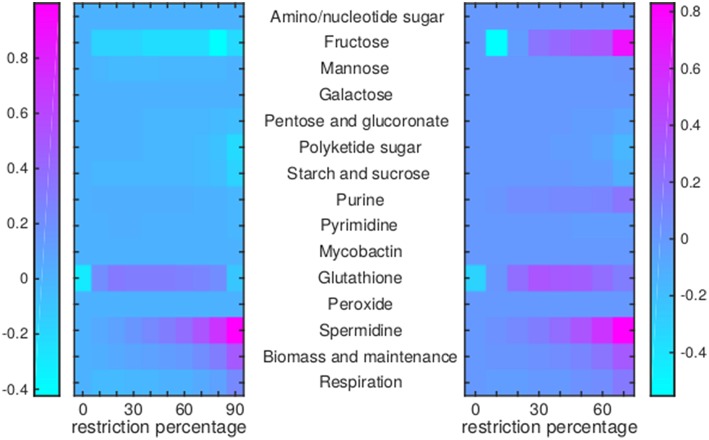
Flux rerouting through sugar metabolism, nucleotide metabolism, and various other metabolic pathways upon application of drugs. Heat maps indicate a predicted relative increase (pink) or decrease (light blue) through various pathways upon the application of a variety of drugs. The logarithm of the sum of all absolute fluxes is given per pathway (values are indicated in the color bars on either side), so information on directionality is not comprised. The x-axis indicates the percentage of restriction of the drug-affected reaction(s). Left: average of BTZ043, cycloserine/terizidone, ethambutol, ethionamide/propionamide, and isoniazid; Right: TMC207.